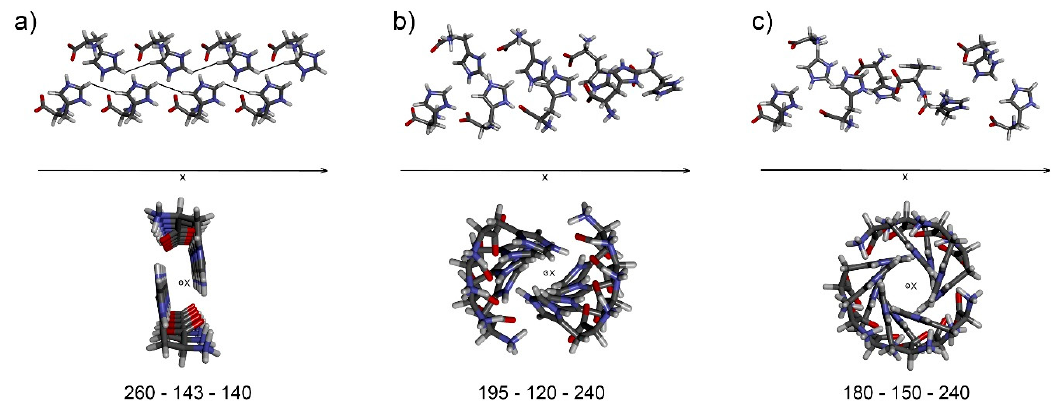
Figure 6. Molecular chains generated for different sets of angles α , β , and θ ; ( a ) 260–143–140, ( b ) 195–120–240, ( c ) 180–150–240.